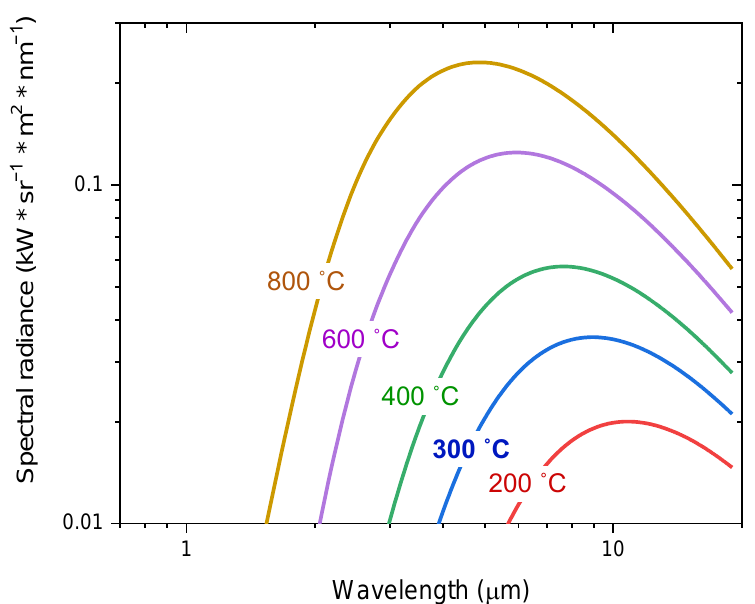
Figure 1. Determination of the wavelength of highest IR emission at different temperatures according to the black body emission spectrum.